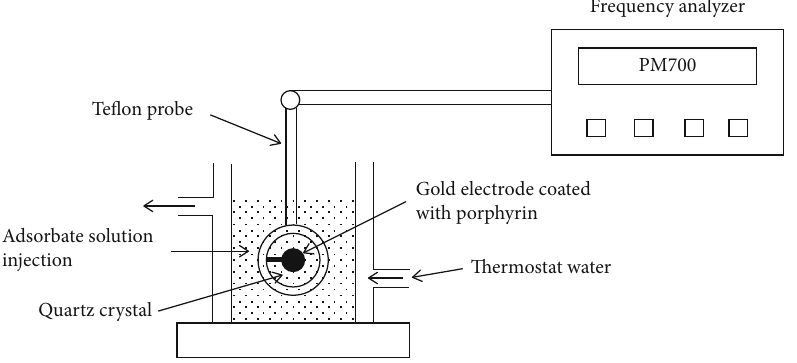
Figure 3: Experimental setup of the quartz crystal